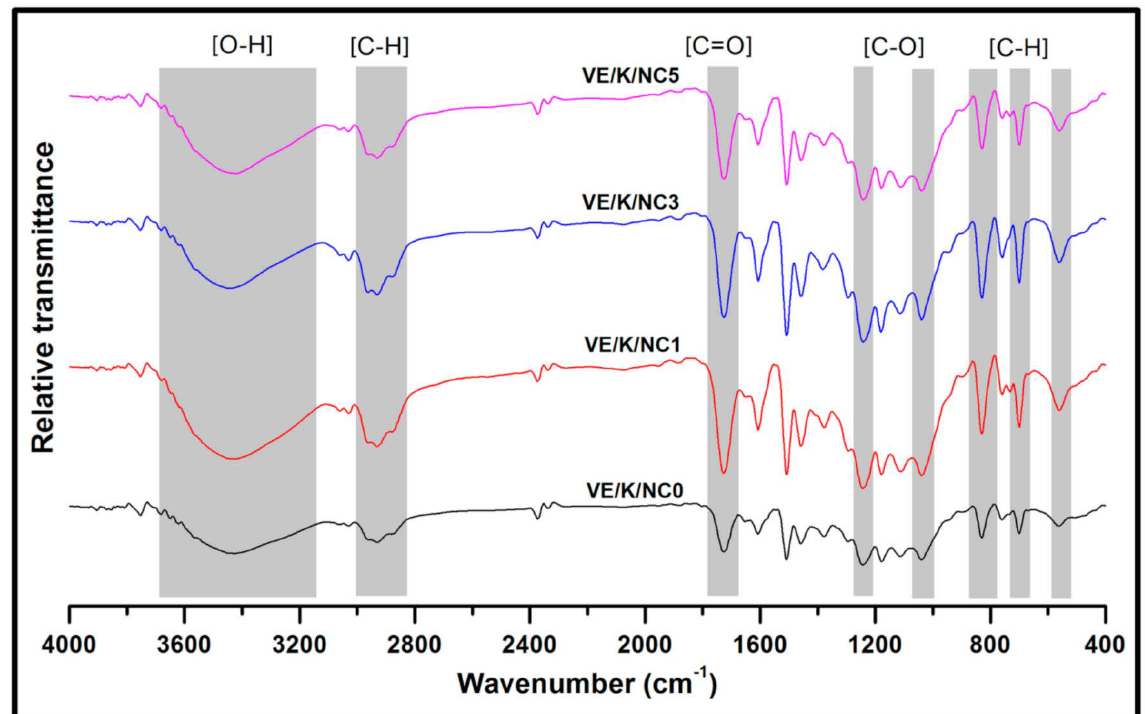
Figure 8. FT-IR spectra of nanocomposites with increasing activated bionanocarbon